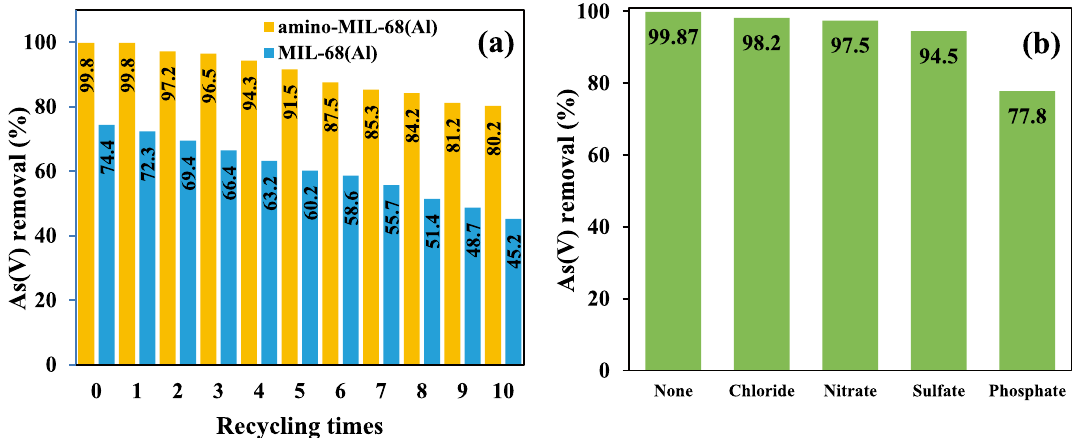
Figure 9. As(V) removal efficiency by amino-MIL-68(Al) and MIL-68(Al) for ten consecutive reuse cycles under optimal conditions ( a ). Interventional effect of anions on As(V) removal efficiency by amino-MIL-68(Al) (The oncentration of anions = 1 mM) ( b